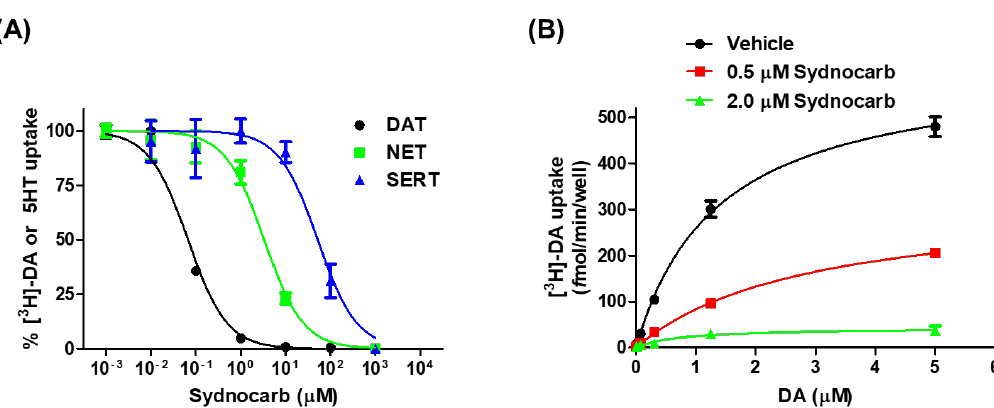
Figure 1. The pharmacology of sydnocarb. ( A ) Radioactive neurotransmitter transport inhibition assay of Sydnocarb against hDAT, hNET, and hSERT in transiently transfected COS-7 cells. Sydnocarb IC 50 values for hDAT, hNET, and hSERT are 0.493 ± 0.14, 34.92 ± 14.09, and 494.87 ± 17.00 µM, respectively. The data were fitted using nonlinear regression, the figure was plotted using average of three independent experiments, and IC 50 mean values and corresponding SEM are displayed. Results are normalized to percent of the highest response in each group. ( B ) [ 3 H]-DA uptake kinetic assay of wild-type DAT transiently transfected COS-7 cells in the absence and presence of 0.5 µM and 2.0 µM Sydnocarb. Data were fitted to Michaelis-Menten equation using nonlinear regression to obtain V max = 634.8 ± 84.62 for the vehicle, 455.6 ± 89.6 femtomole/min/well in the presence of 0.5 µM Sydnocarb, and 195 ± 80.7 femtomole/min/well in the presence of 2.0 µM Sydnocarb, along with the respective K M values of 1.4 ± 0.21, 3.3 ± 0.78, and 1.7 ± 0.43 µM. The figure displays the average behavior from four independent experiments used to evaluate the V max and K M . For the V max , the vehicle versus 0.5 µM and 2.0 µM Sydnocarb showed significant differences ( p < 0.05) when compared using one-way ANOVA with Dunnett’s post-hoc test. No statistical significance was found in the K M values.